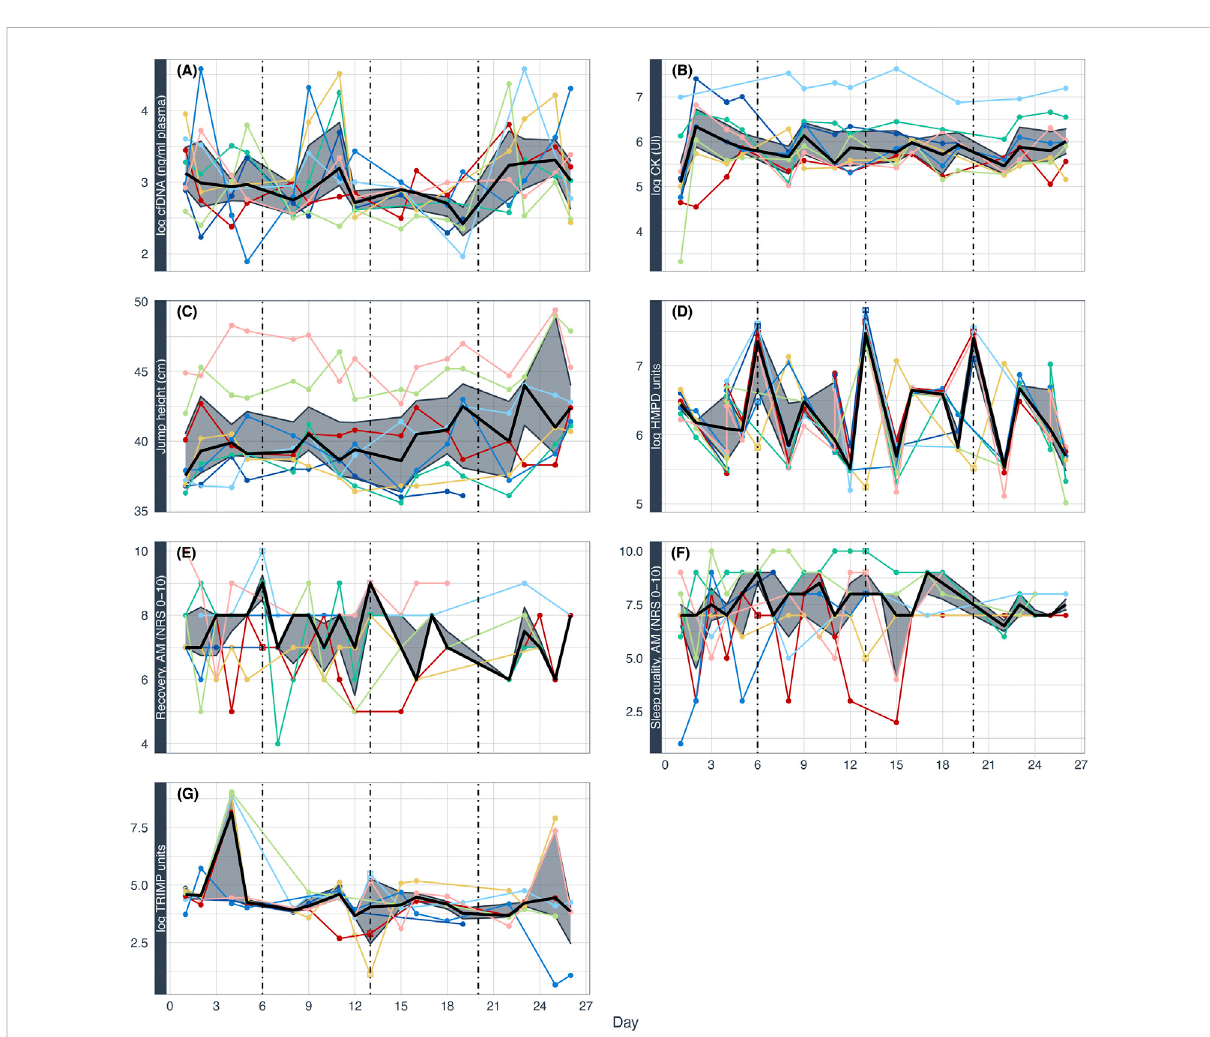
FIGURE 2 Selectedvariablesoverthecourseof4weeksinalleightplayers.cfDNA(cell-freeDNA) (A) andCK(creatinekinase) (B) ,countermovementjump height (C) , HMPD (high metabolic power distance) (D) , perceived recovery (E) , sleep quality (F) , and training impulse (TRIMP) (G) . For each plot, each player is visualized with the same color. The black line displays the median of the variable, the grey ribbon the interquartile ranges. Dashed lines represent games on days 6, 13, and 20. cfDNA, CK, TRIMP, and HMPD log(logarithmized)-transformed, jump height in cm and questionnaire scoresonascalefrom0to10.LogHMPDondayssixand20couldonlybecalculatedbyaveragingtheindividualavailabledataforeachmatchperiod due to the lack of data from the LPS